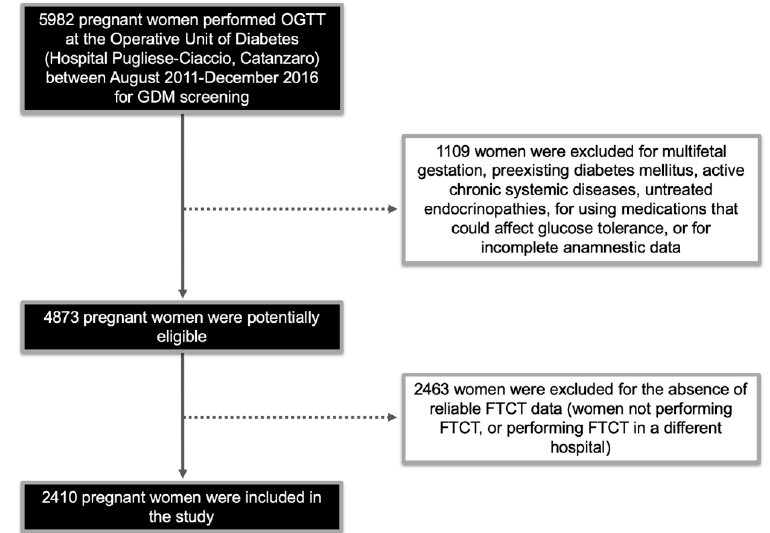
Figure 1. Flow chart indicating the selection of the study population. OGTT: oral glucose tolerance test; GDM: gestational diabetes mellitus; FTCT: first trimester combined test. Table 1. Clinical and biochemical characteristics of the study population undergone first trimester combined test (FTCT) and gestational diabetes mellitus (GDM) screening tests.